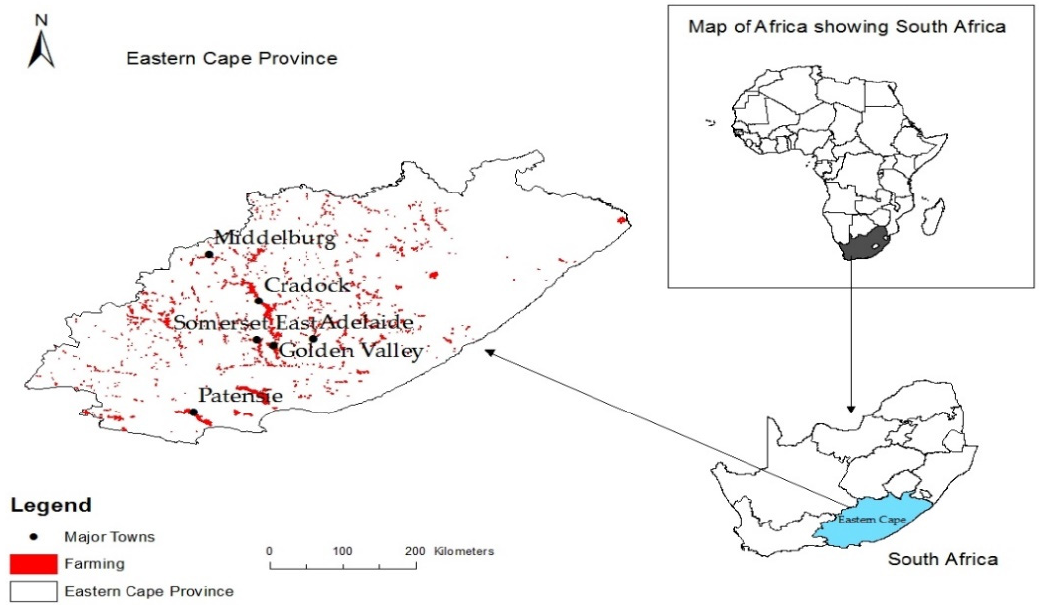
Figure 1. Map of study area indicating the dominant farming towns in the Eastern Cape Province, South Africa. The figure is taken from [32].